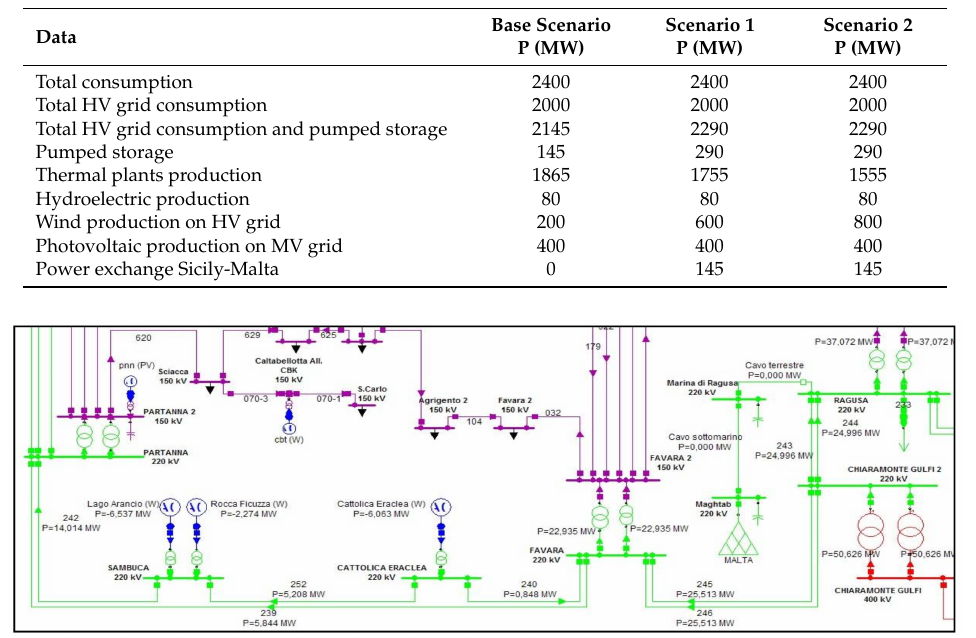
Table 1. Data used in various scenarios.